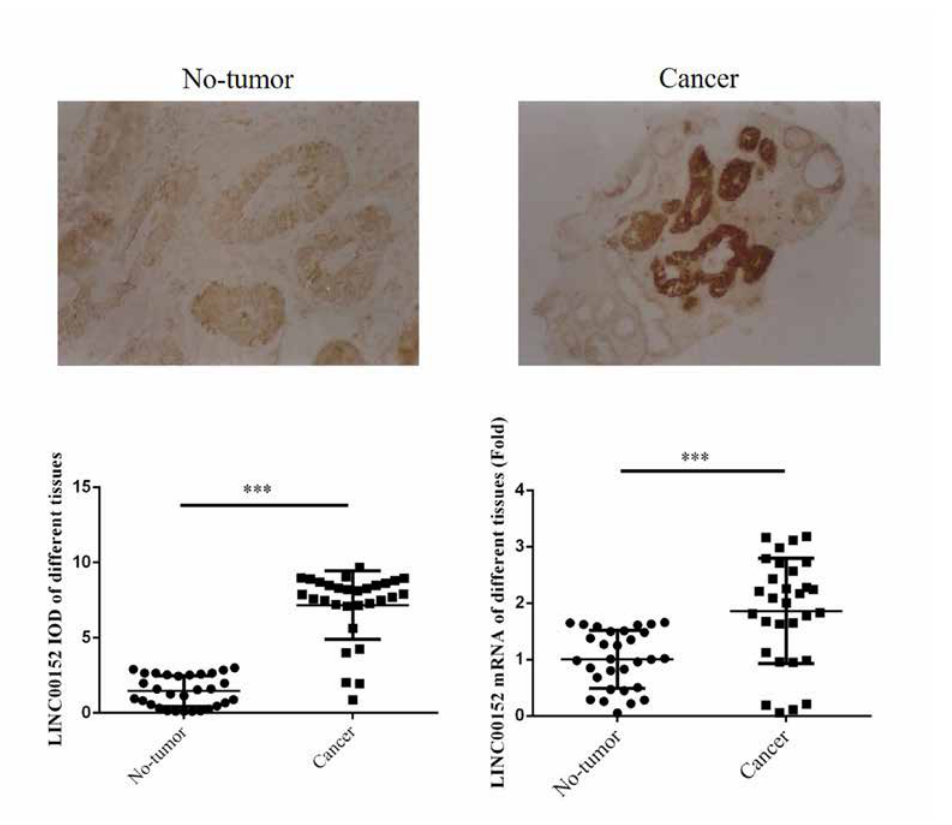
Figure 1. The LINC00152 expression of different tissues by ISH and RT-qPCR ( × 100) ***:P ＜ 0.001, compared with no-tumor